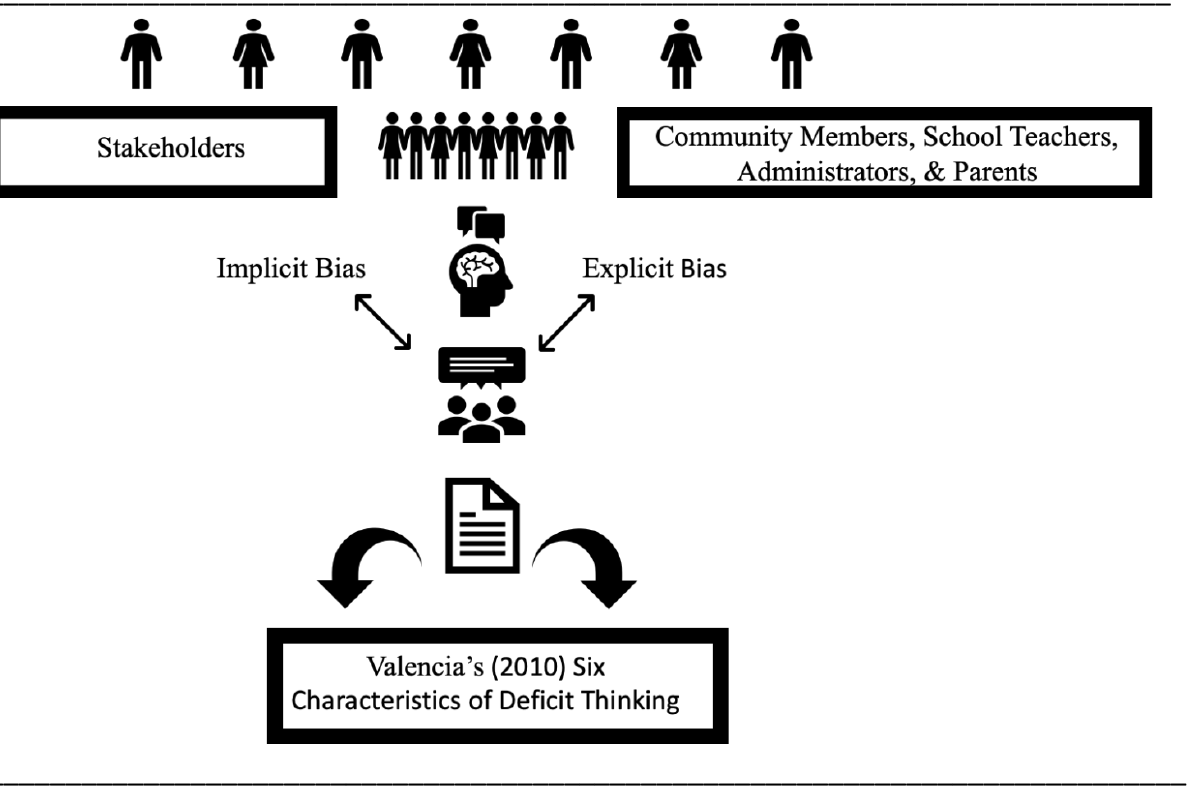
Figure 1: Conceptualization of a Deficit Thinking Structure on School Policies, Procedures, and